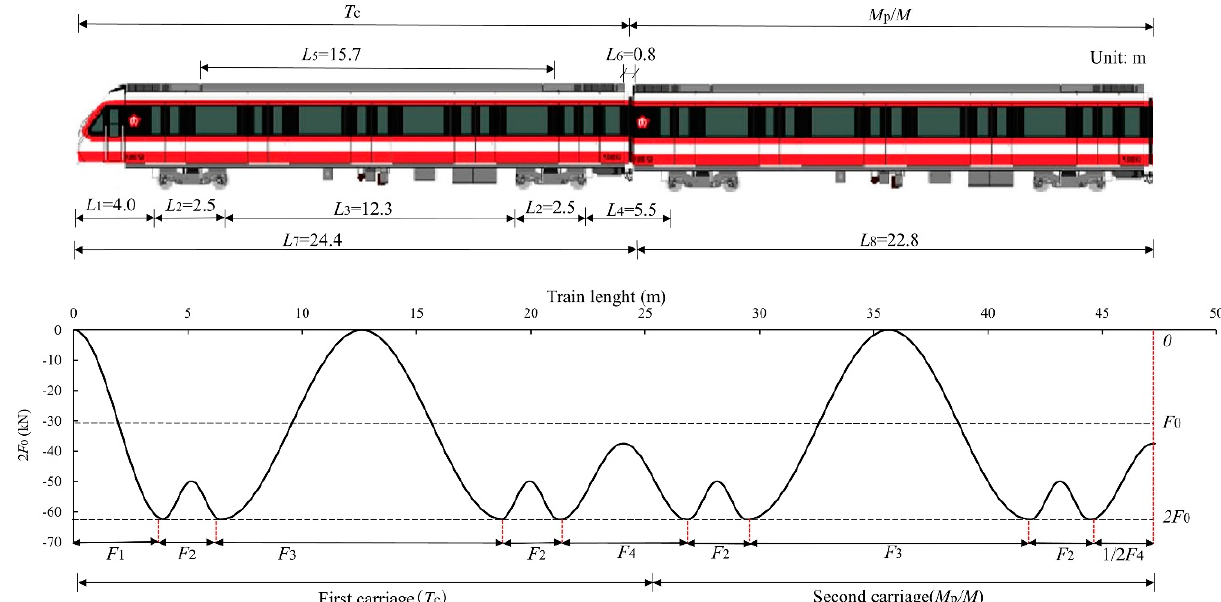
Figure 2. Vibration load caused by type A trains running at 120 km/h.